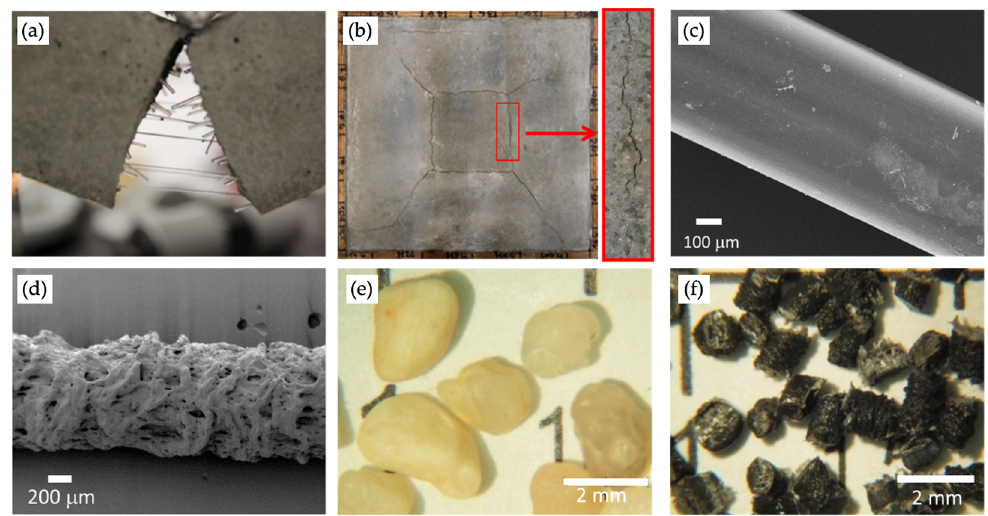
Figure 4. ( a ) Polymeric fibers bridging the two sides of a mortar sample after a flexural test; ( b ) shrinkage cracking phenomena occurring after an accelerated test; ( c ) FE-SEM micrograph of a smooth PP fiber; ( d ) FE-SEM micrograph of an engineered roughened fiber; ( e ) silica sand; and ( f ) artificial aggregates prepared using a secondary raw material.